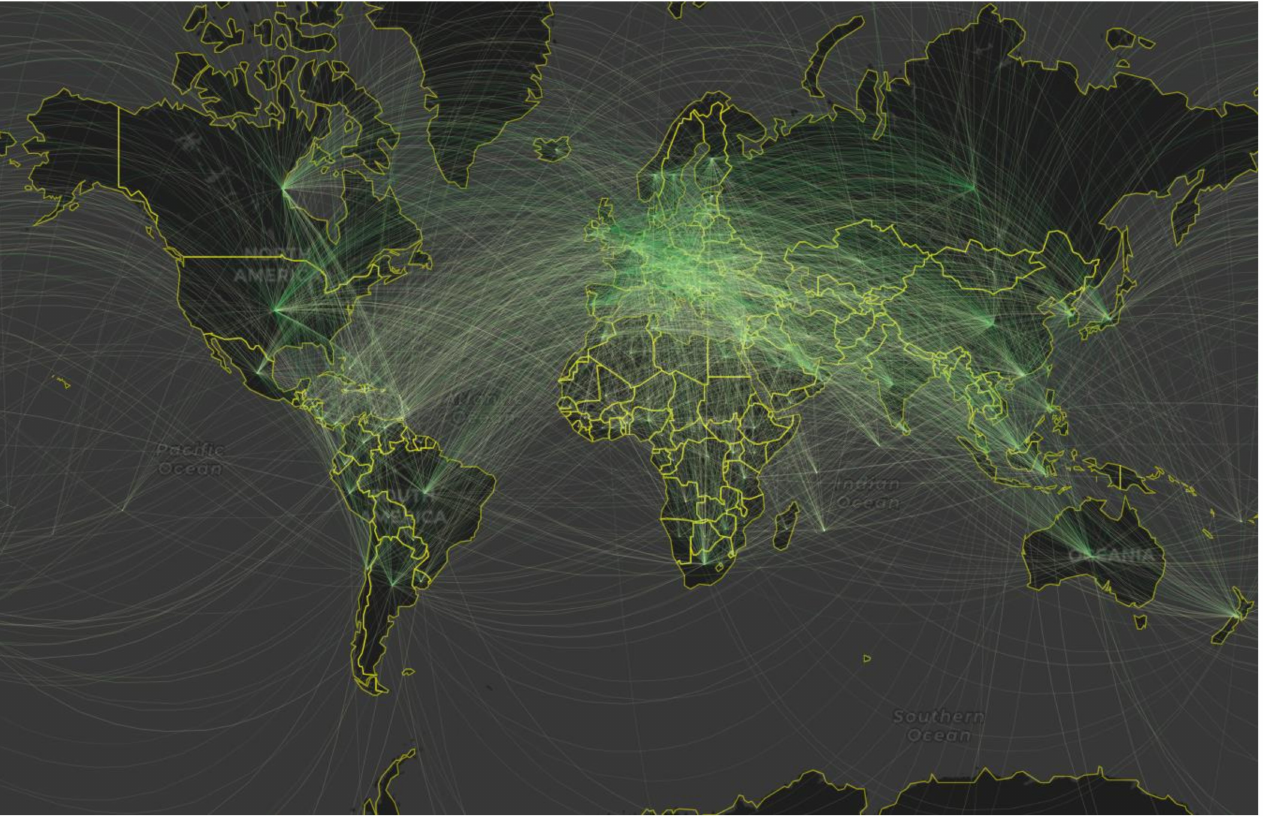
Figure 1. Interactive world tourism web. Note: The map displays only the arcs with weight > 1000. Source: authors. Available online: https://www.mdpi.com/2076-3417/11/5/2253/s1 (accessed on 7 March